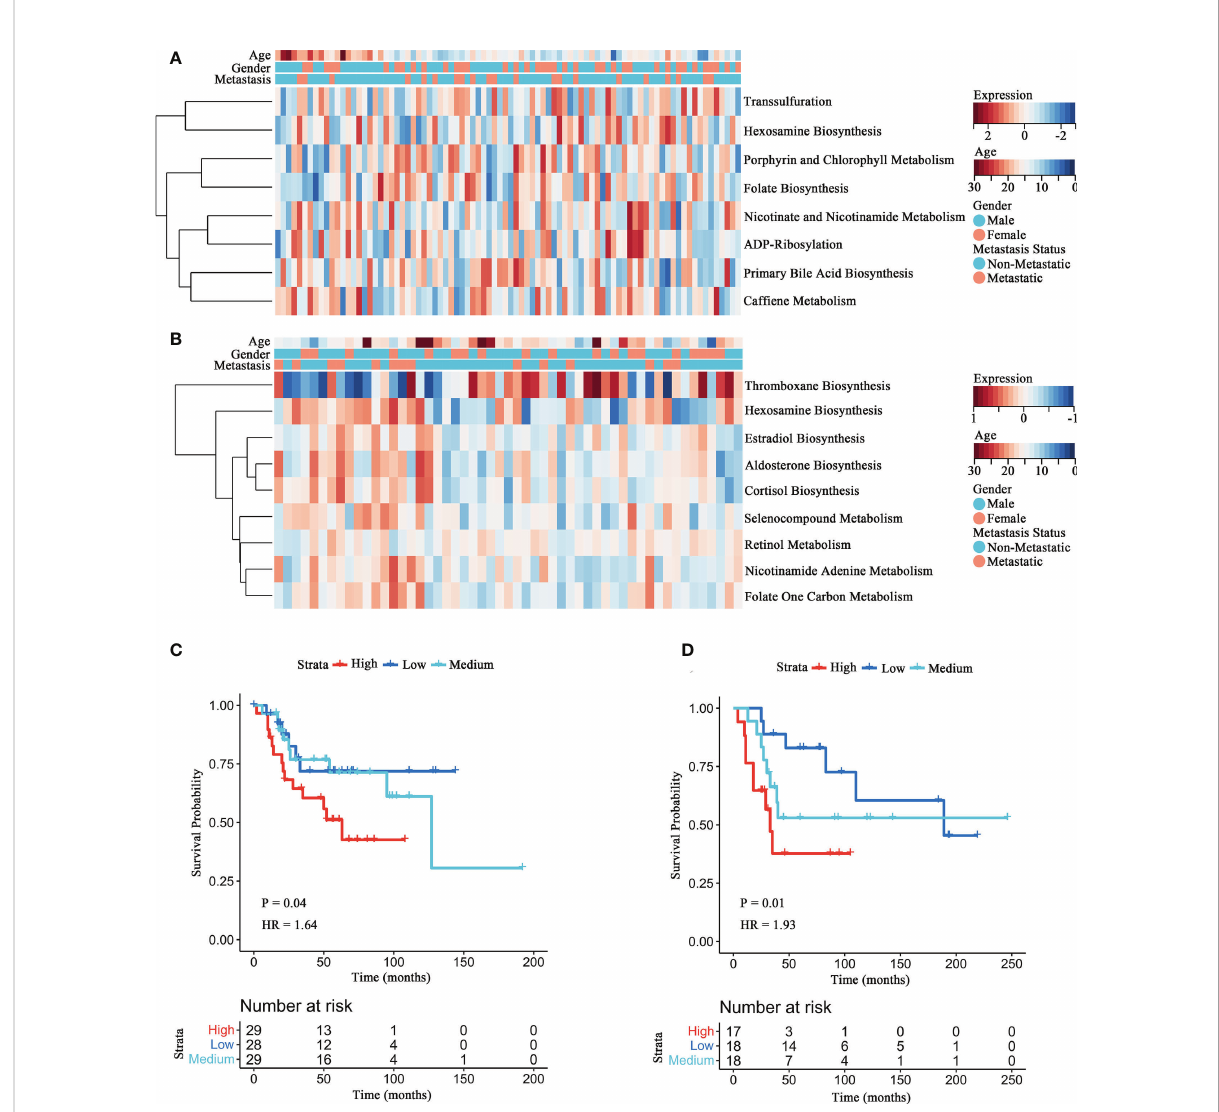
FIGURE 1 Identi fi cation of the HBP pathway associated with overall survival in OS patients. (A, B) The heatmaps of survival-associated metabolic signatures in Target-OS (A) and GSE21257 (B) cohorts. (C, D) Survival analyses of the HBP pathway for Target-OS (C) and GSE21257 (D) cohorts show considerable differences between the high and low GSVA score